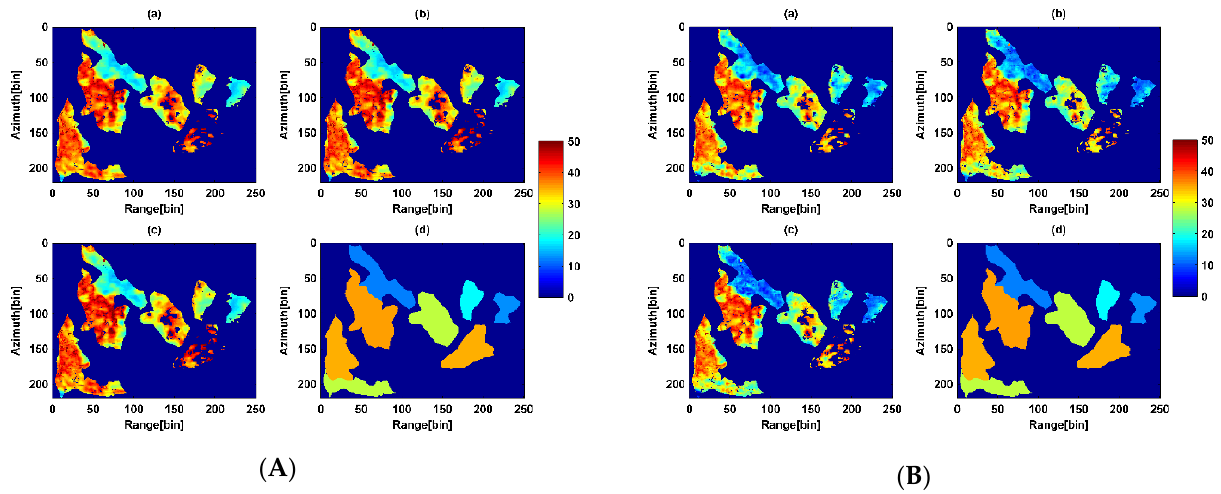
Figure 13. Improved three-stage method for forest height inversion of ESA PolInSAR data. ( A ) Three-stage method for forest height inversion based on coherence optimization ( a ) HV ( b ) PD ( c ) MCD ( d ) The average stand forest height of field measurement ( B ) Introduction of coherence amplitude for Forest height inversion ( a ) HVWeight ( b ) PDWeight ( c ) MCDWeight ( d ) The average stand forest height of field measurement.